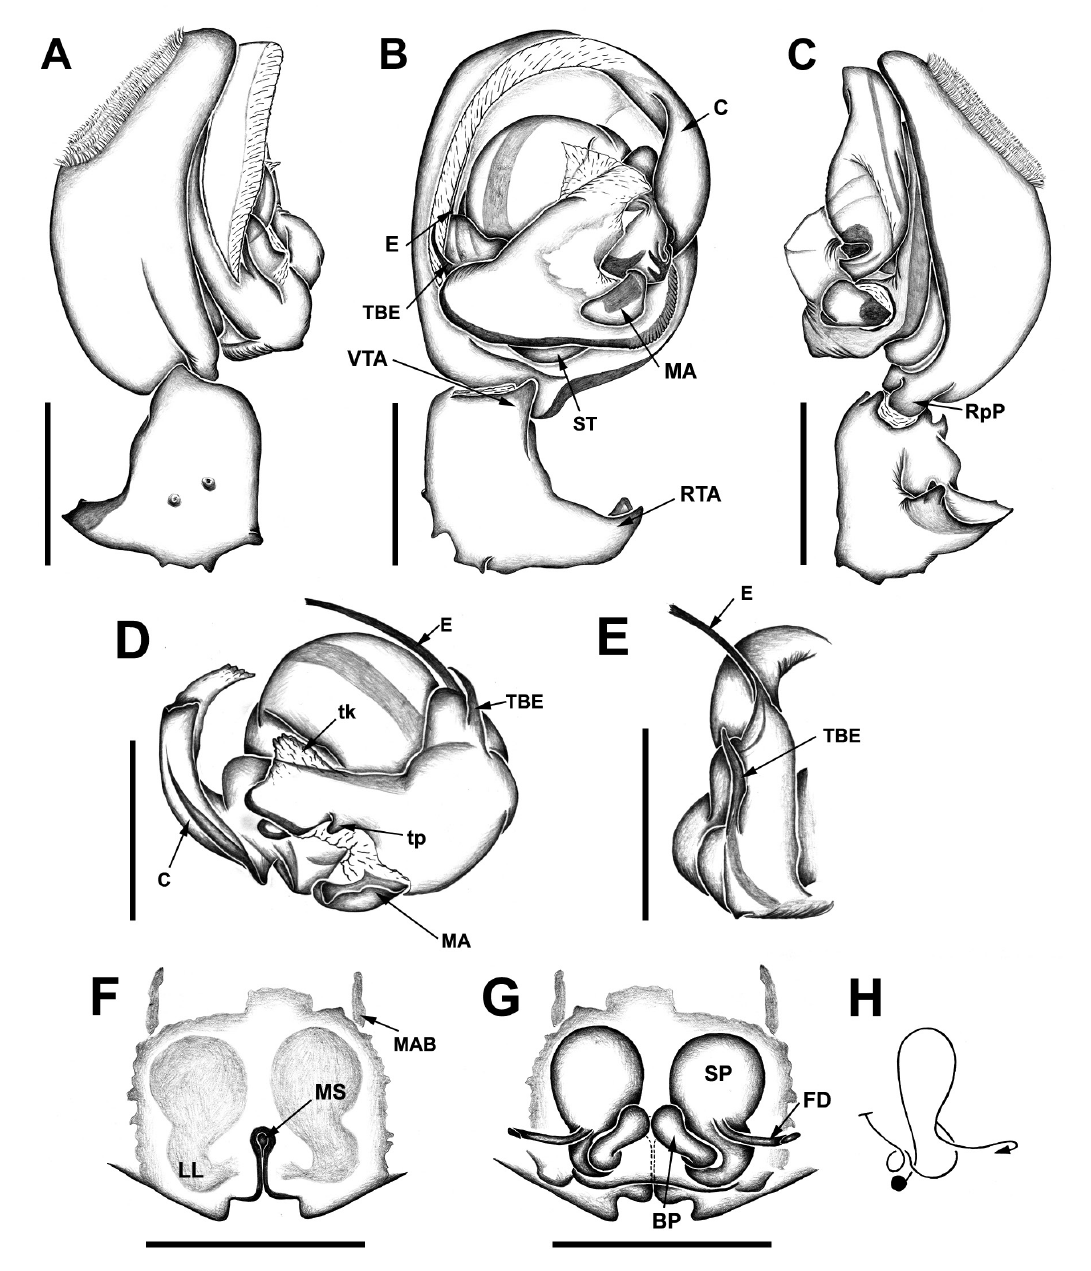
Fig. 10. Cuiambuca vacabrava sp. nov. A − C . Holotype, ♂ (IBSP 60013). D − F . Paratype, ♀ (IBSP 43277). A . Left palp, prolateral view. B . Left palp, ventral view. C . Left palp, retrolateral view. D . Right palp, bulb, ventral view. E . Right palp, detail of embolus base, prolateral view. F . Epigyne, dorsal view. G . Vulva, ventral view. H . Schematic course of internal duct system. Abbreviations: BP = blind ending projection; C = conductor; CD = copulatory duct; FD = fertilization duct; LL = lateral lobe; MA = median apophysis; MAB = muscle attachment bands; MS = median septum; RpP = retroproximal cymbial projection; RTA = retrolateral tibial projection; SP = spermathecae; ST = subtegulum; sTBE = secondary tegular projection close to embolus base; TBE = tegular projection close to embolus base; tk = tegular keel; tp = tegular protrusion; VTA = ventral tibial projection. Scale bars = 5